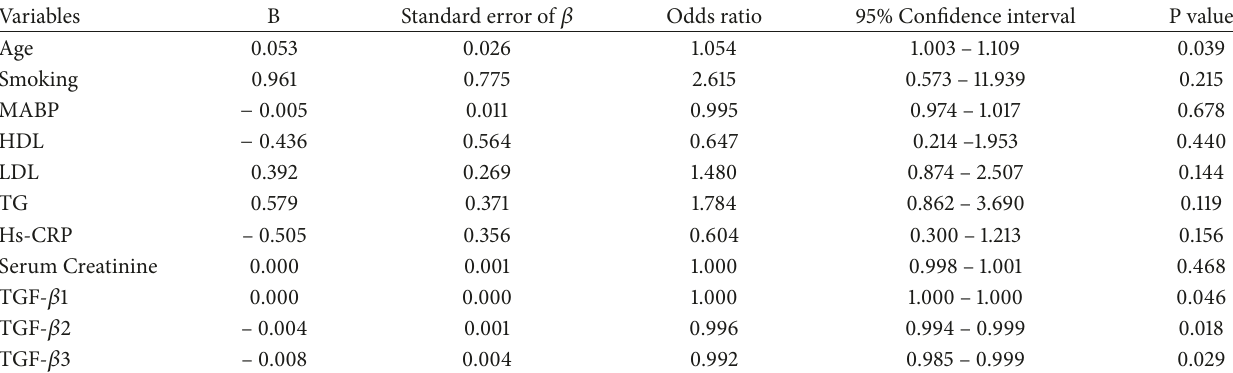
Table 4: Multiple logistic regression analysis of risk factors for atherosclerosis in CKD patients.